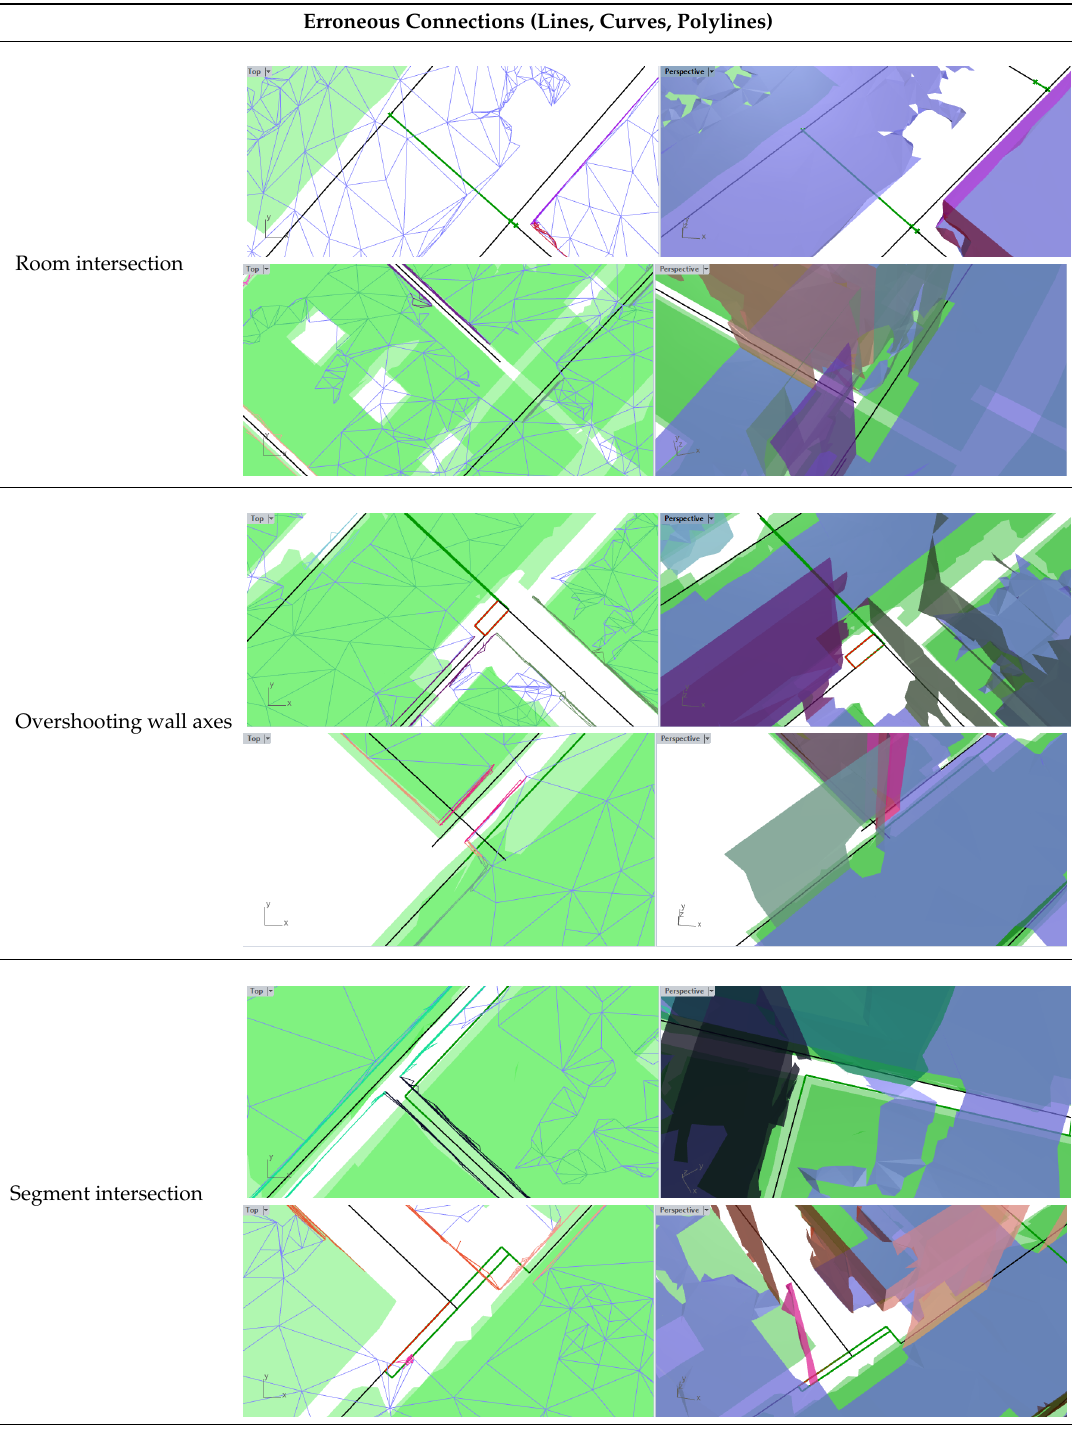
Table 3. Erroneous topology reconstruction results of interlocking walls in complex scenarios. Partial walls are shown in black, potential connection in green and final connections in red. The green surfaces depict the IfcSpace geometry and the floor segments are shown in